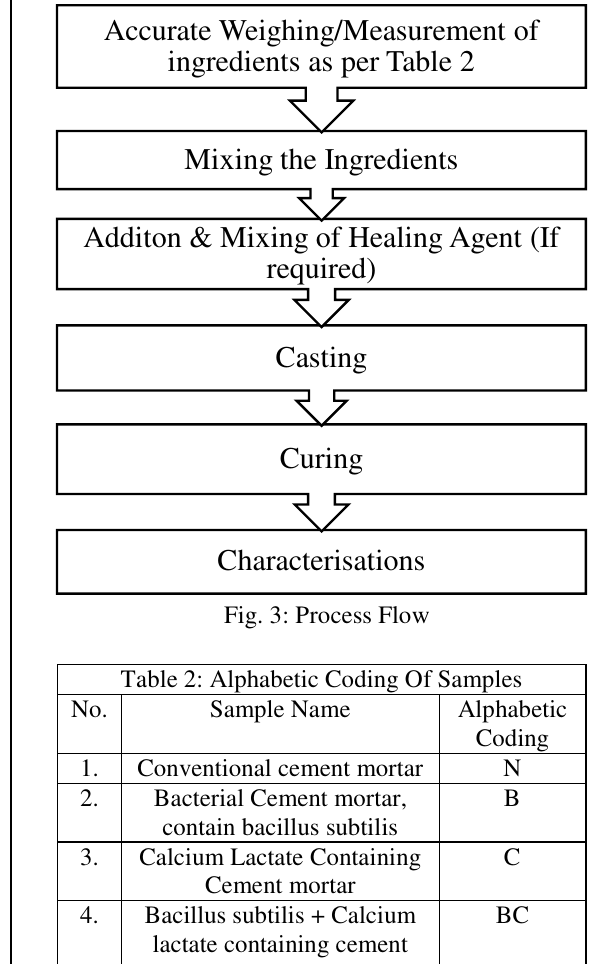
Fig. 2: Bacterial Colonies Grown